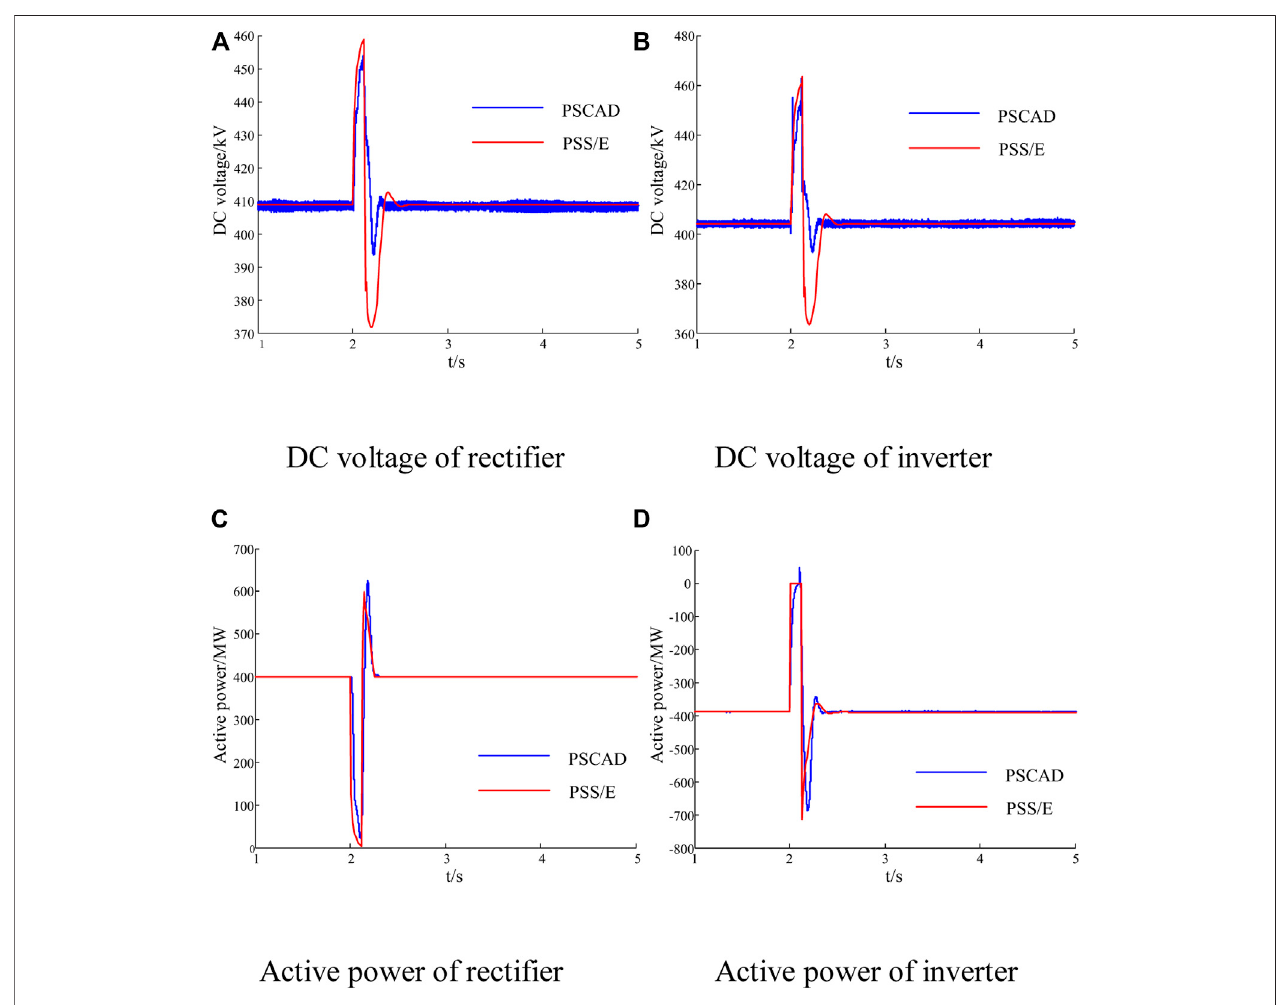
FIGURE14| DynamicresponseoftheMMC-HVDCsysteminPSCAD andPSS/E. (A) DCvoltageofrecti fi er (B) DC voltageofinverter. (C) Activepower ofrecti fi er (D) Active power of inverter.